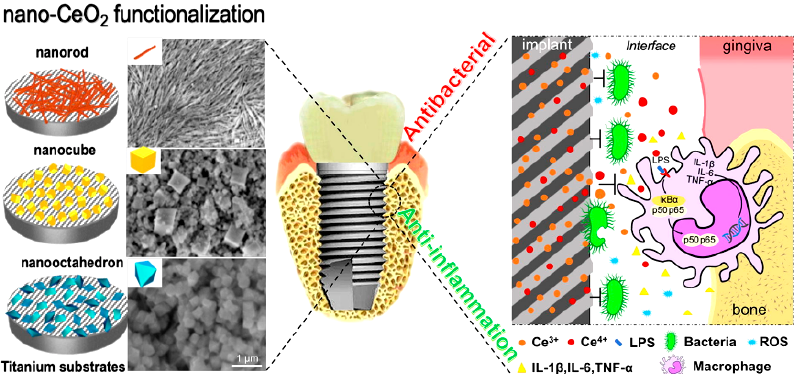
Figure 12. A schematic showing the Ti surface modification by nano-CeO 2 (rod-CeO 2 , cube-CeO 2 , octa-CeO 2 ) for antibacterial and anti-inflammatory properties. Readers are referred to [138] (reproduced with permission number: 5071081046141, Elsevier) for more information.